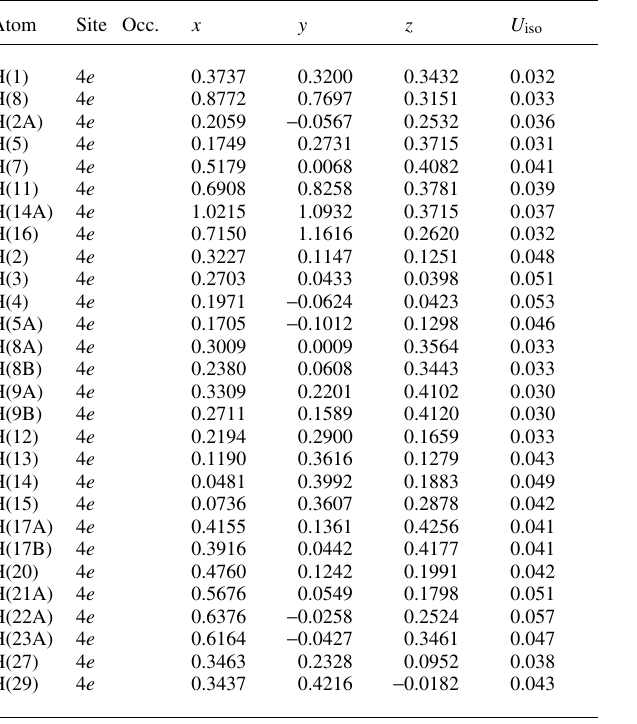
Table 2. Atomic coordinates and displacement parameters (in Å 2 ) .